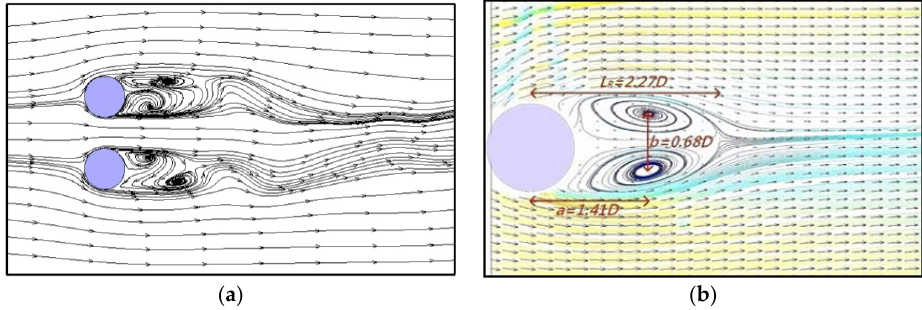
Figure 3. Streamline distribution. ( a ) T/D = 1.75, G/D = 8.0, ( b ) The particle image velocimetry (PIV) results at Re = 17,980 (Zhou et al., 2015. [27]).